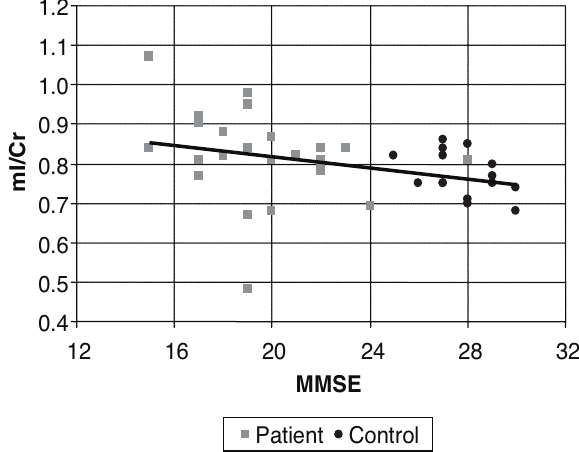
Figure 4. Scatter plot for MMSE and ml/Cr in the cingulate. ml/Cr, mioinositol/creatine ratio.